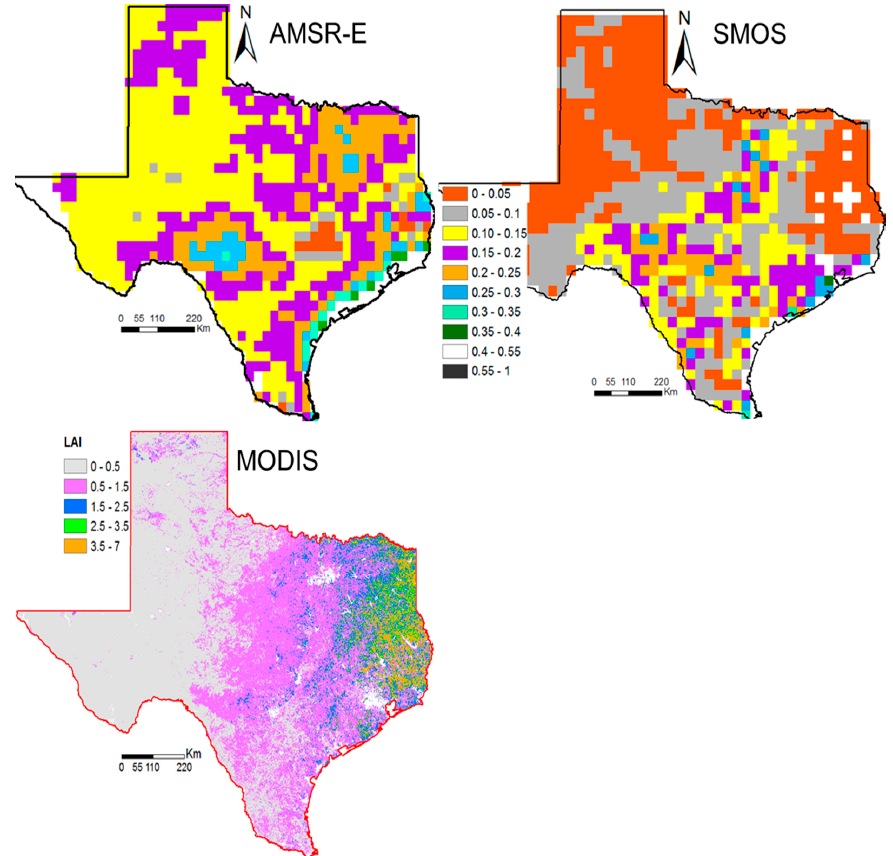
Figure 3. Annual precipitation at selected stations (2010–2015).